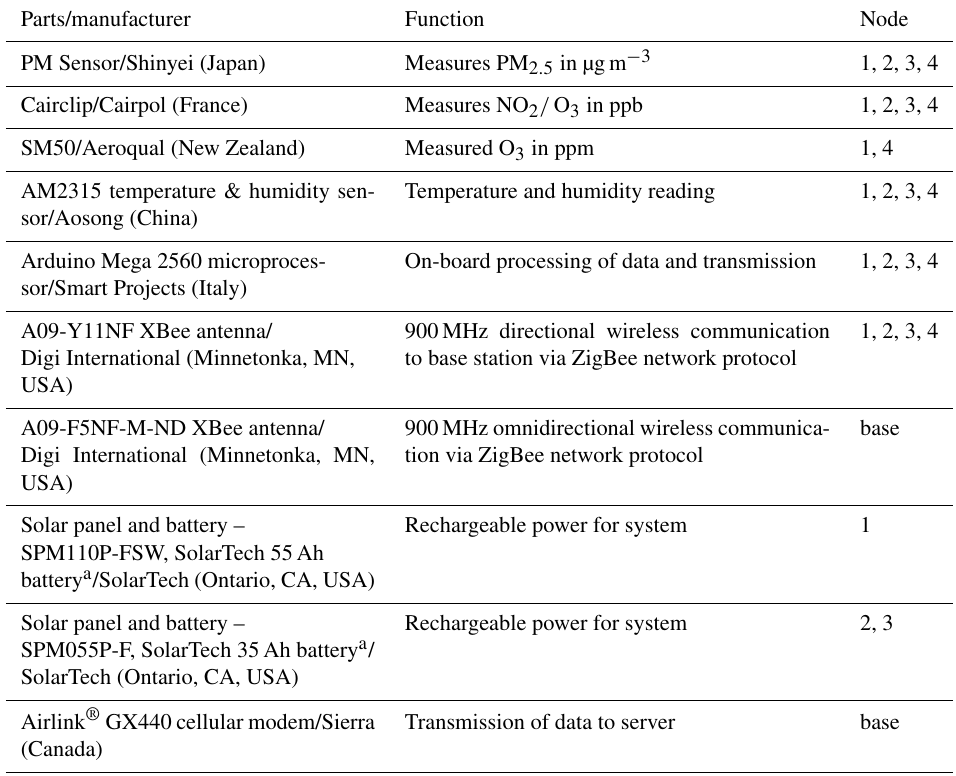
Table 2. Wireless sensor network